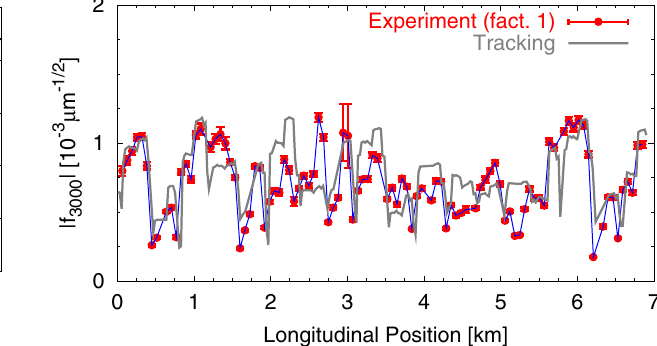
FIG. 8. (Color) Normalized amplitude of the spectral line (cid:2)(cid:1) 2 ; 0 (cid:3) versus horizontal kick amplitude for one